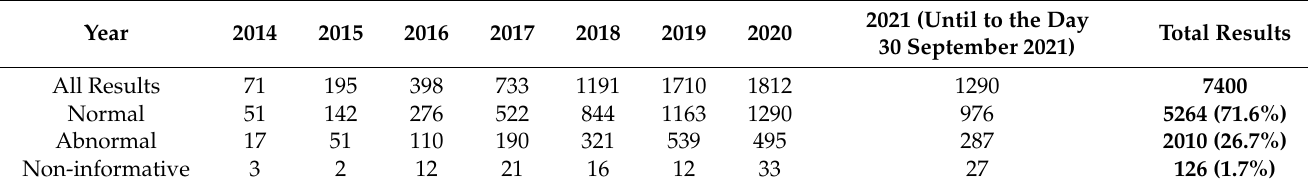
Table 1. Number of tests performed in a particular year along with the number of correct, incorrect, and non-informative